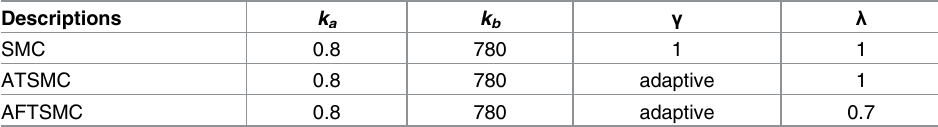
Table 2. Controller parameters of the proposed methods.